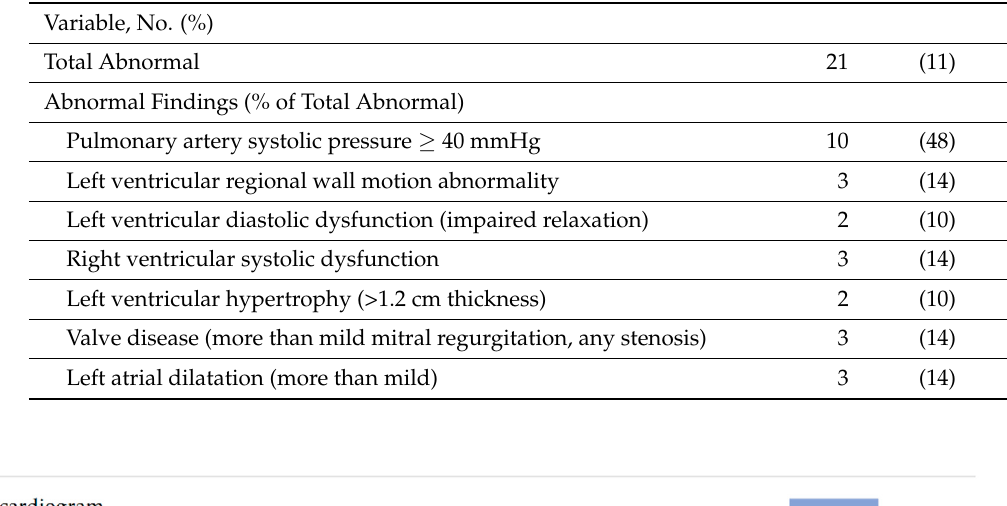
Table 3. Abnormal findings on echocardiography among low-risk pregnant women.